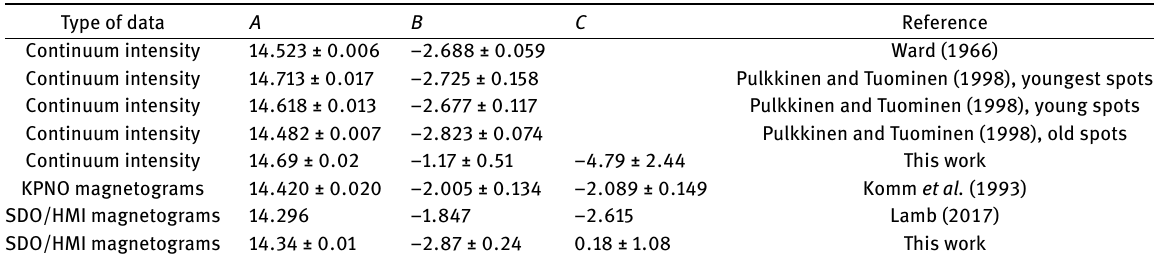
Table 1. Derived differential rotation constants A , B , and C (equation 1). The differential rotation constants derived in other works are listed for comparison. The units are degrees day −1 .